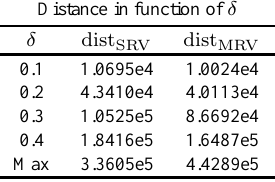
Table 1 Distance in function of